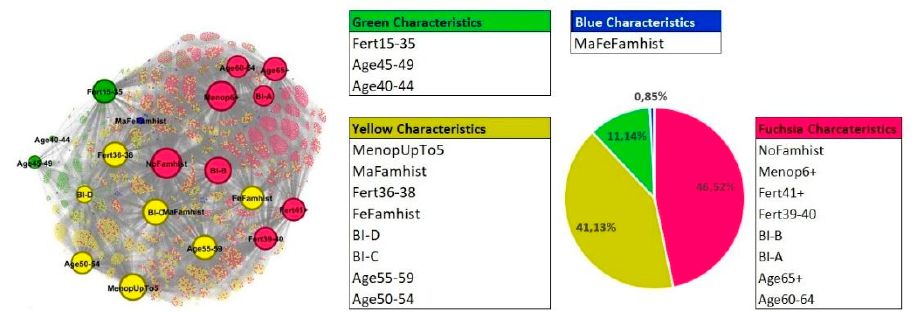
Figure 2. Graph layout and composition of communities within the profile 1. The pie chart represents the percentages of women belonging to each community.